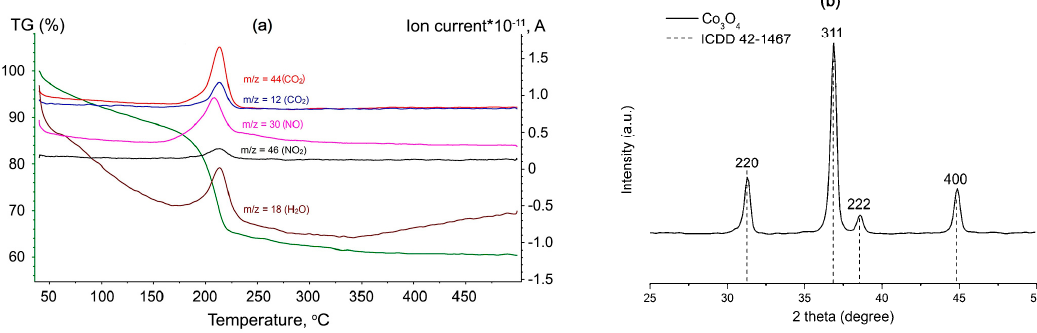
Figure 1. ( a ) TG-MS curves for of the dried precipitate; ( b ) X-Ray diffraction patterns of Co 3 O 4